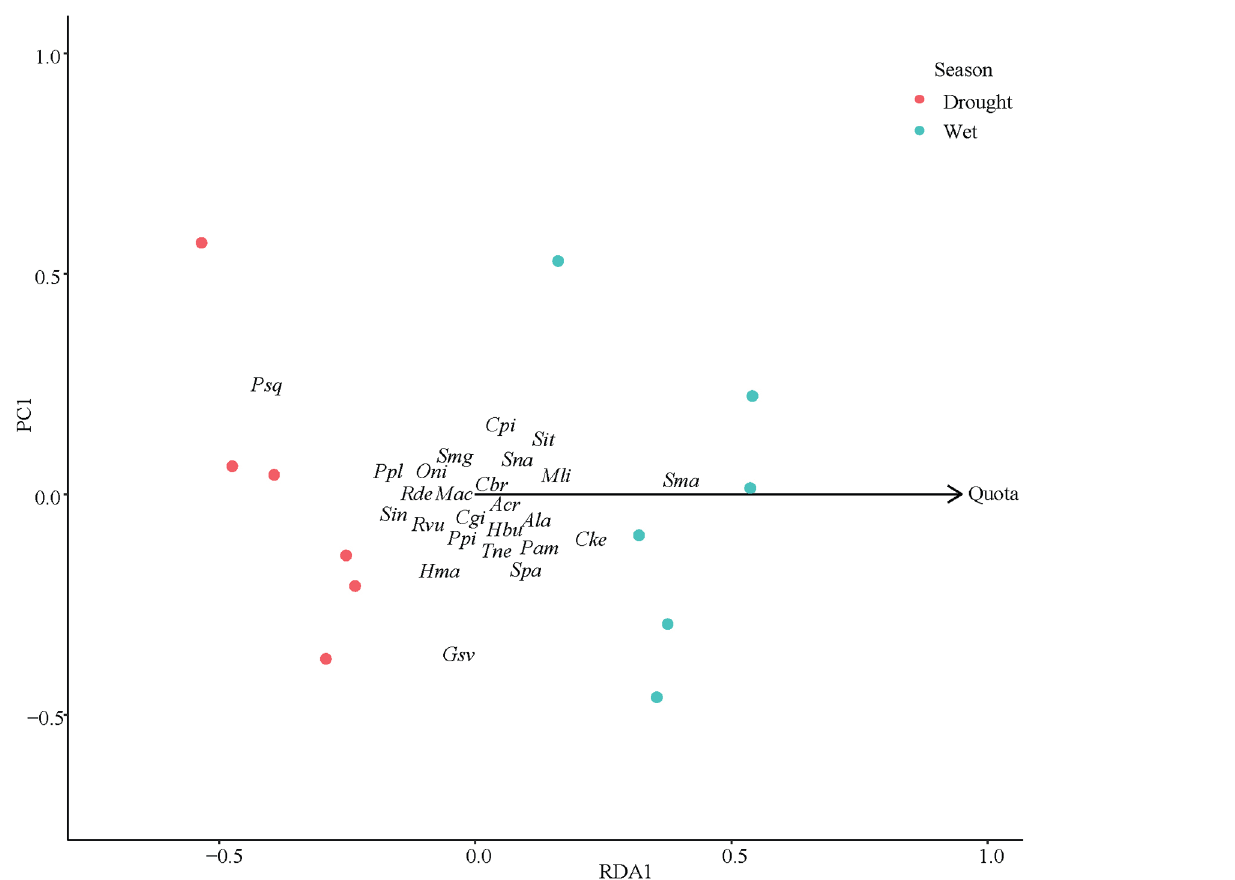
FIGURE 5 | Redundancy analysis (RDA). Relation of ichthyofauna to the significant environmental variable (quota) in the drought and wet seasons in an area without the influence of fish farming (Control) at the Ilha Solteira reservoir, Upper Paraná River, São Paulo, Brazil. Ala = Acestrorhynchus lacustris , Acr = Astronotus crassipinnis , Cke = Cichla kelberi , Cpi = Cichla piquiti , Cbr = Cyphocharax gillii , Cgi = Crenicichla britskii , Gsv = Geophagus sveni , Hma = Hoplias aff. malabaricus , Mac = Megalancistrus parananus , Mli = Metynnis lippincottianus , Oni = Oreochromis niloticus , Ppl = Pimelodus platicirris , Ppi = Pinirampus pirinampu , Psq = Plagioscion squamosissimus , Pam = Pterygoplichthys ambrosettii , Rvu = Rhaphiodon vulpinus , Rde = Roeboides descalvadensis , Spa = Satanoperca pappaterra , Sin = Steindachnerina insculpta , Sit = Schizodon intermedius , Sna = Schizodon nasutus , Sma = Serrasalmus maculatus , Smg = Serrasalmus marginatus , Hbu = Heterotilapia buttikoferi , and Tne = Triportheus nematurus